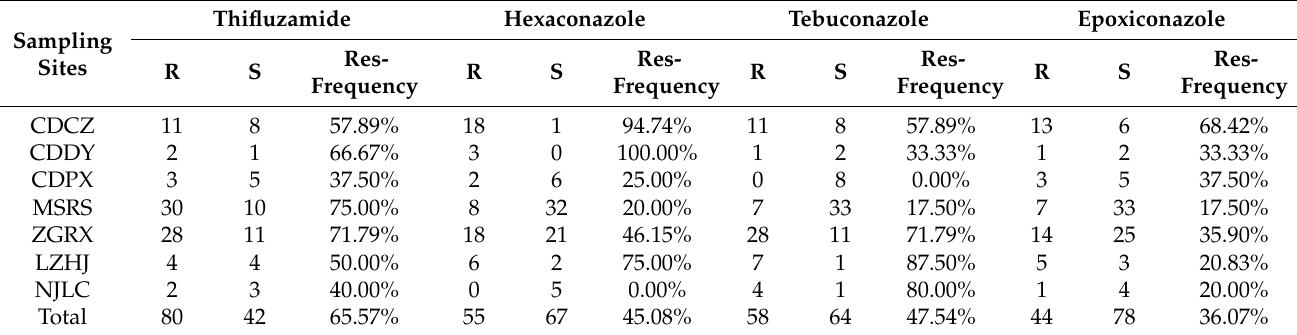
Table 1. The frequency of resistance to R. solani isolates in Sichuan Province.